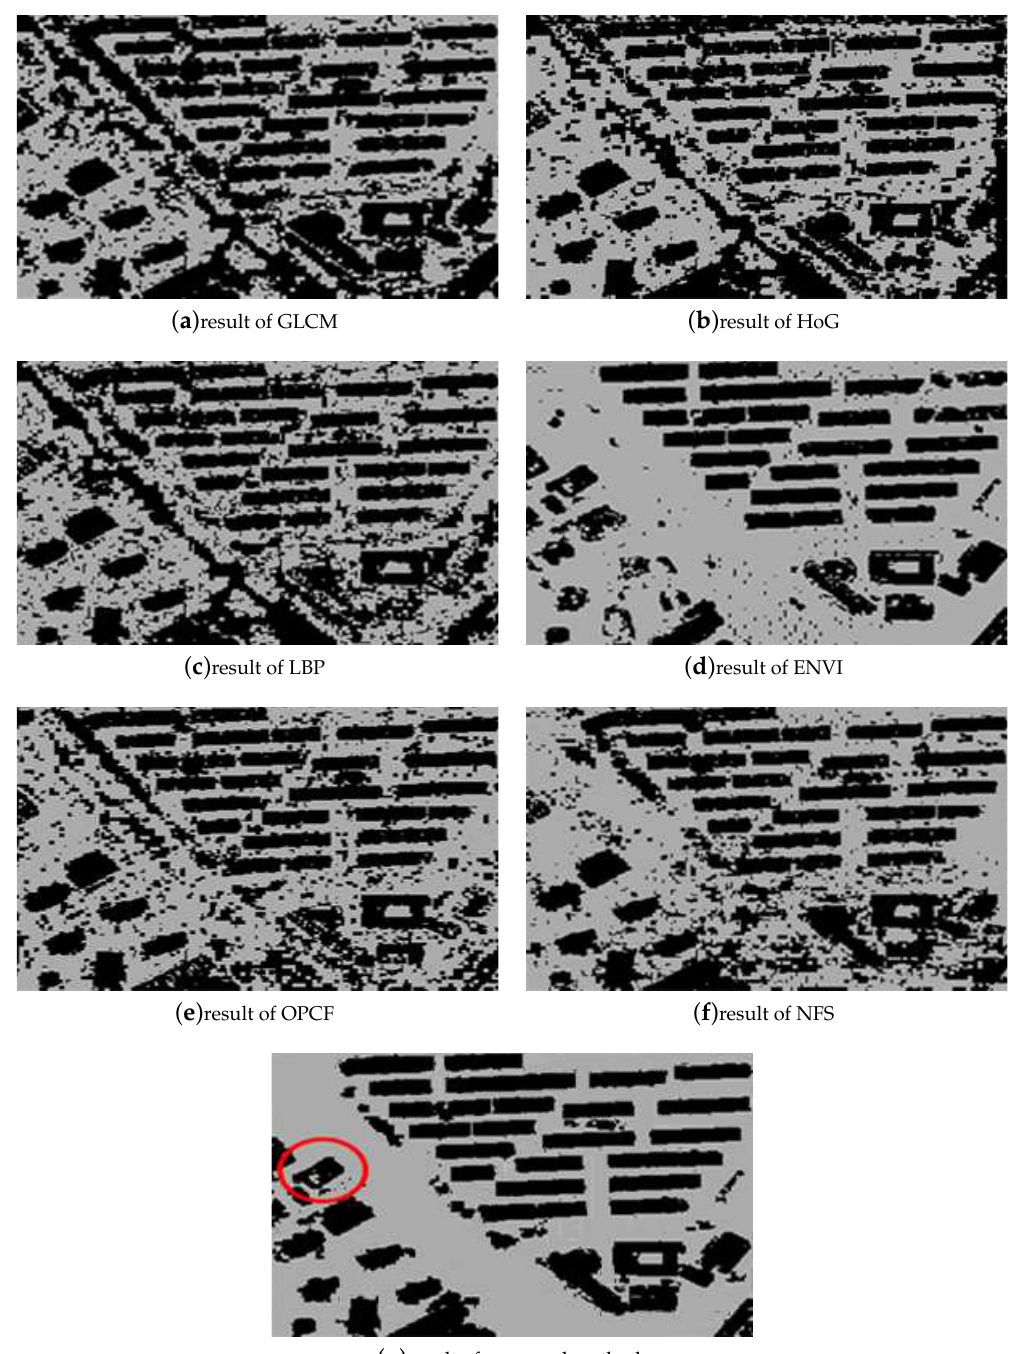
Figure 11. Building extraction results of